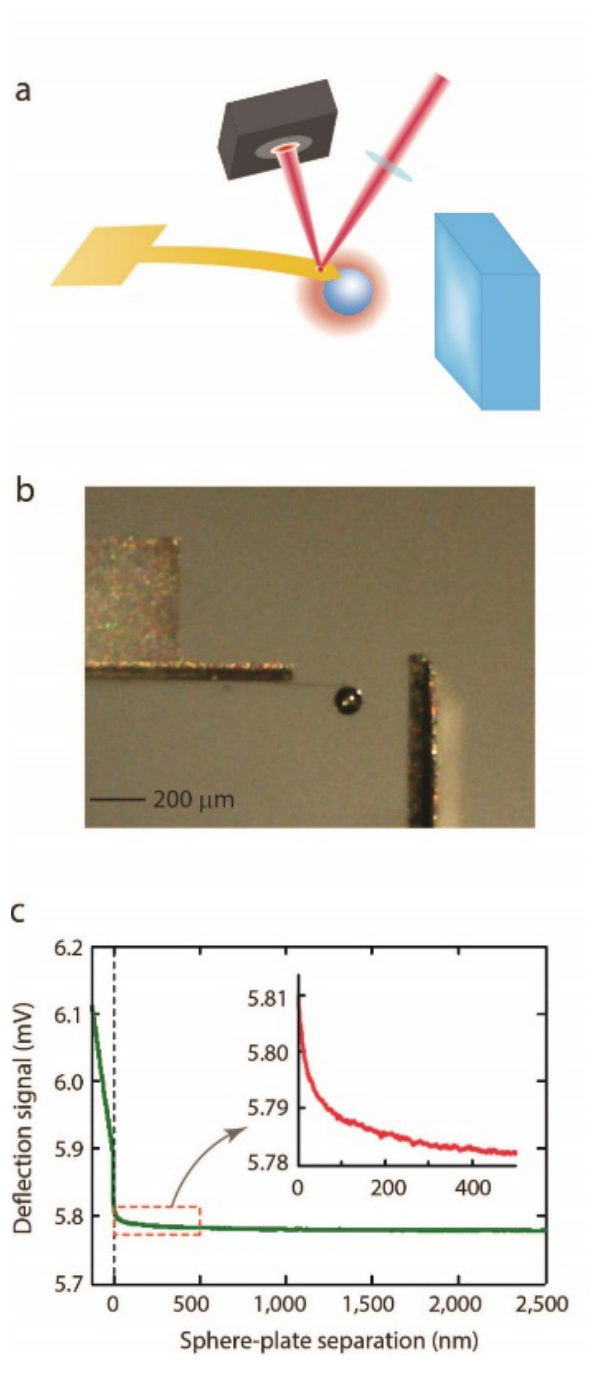
Figure 8: Experimental set-up for near-field thermal measurements. (a) Schematic of the experiment set-up that shows the relative po- sition between the optical deflection system and the sample. (b) Optical image of the set-up. (c) Typical cantilever deflection signals when the sphere approaches the substrate. The contact point be- tween the sphere and the plate is marked by the vertical dashed black line. Inset: Deflection signals close to the contact point